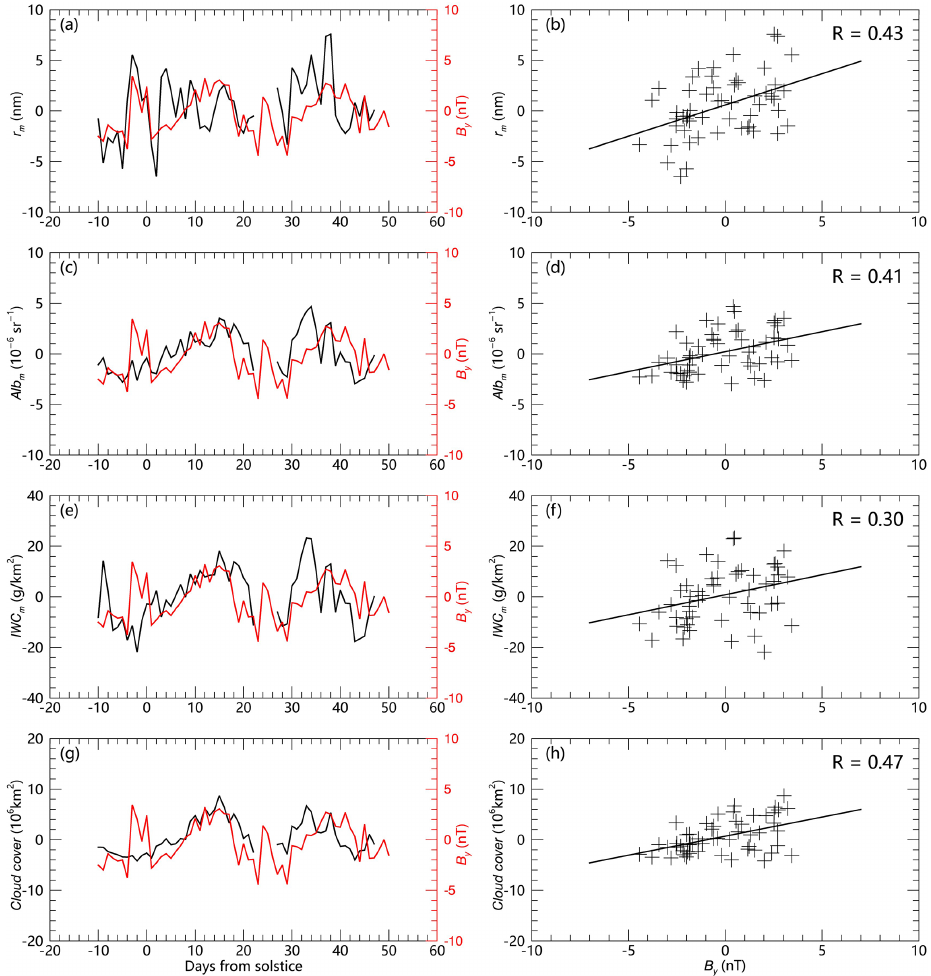
Figure 2. The left panels (a, c, e, g) show the relationships of the daily IMF B y (red curves) with the anomaly of mean ice particle radius ( r m ), mean albedo (Alb m ), mean ice water content (IWC m ) and cloud cover in the 2008/2009 NLC season for the SH. The anomaly of NLC data is obtained by removing the 40d running mean. The right panels (b, d, f, h) present the correlation coefficients between the daily IMF B y and the anomaly of NLC